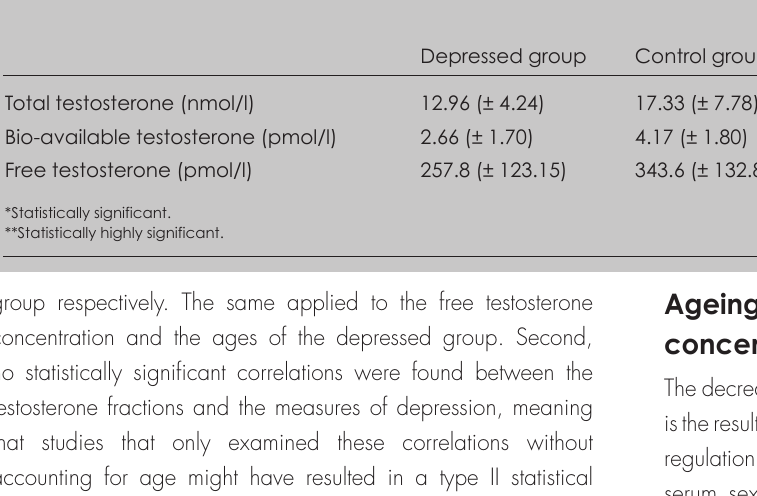
Difference between